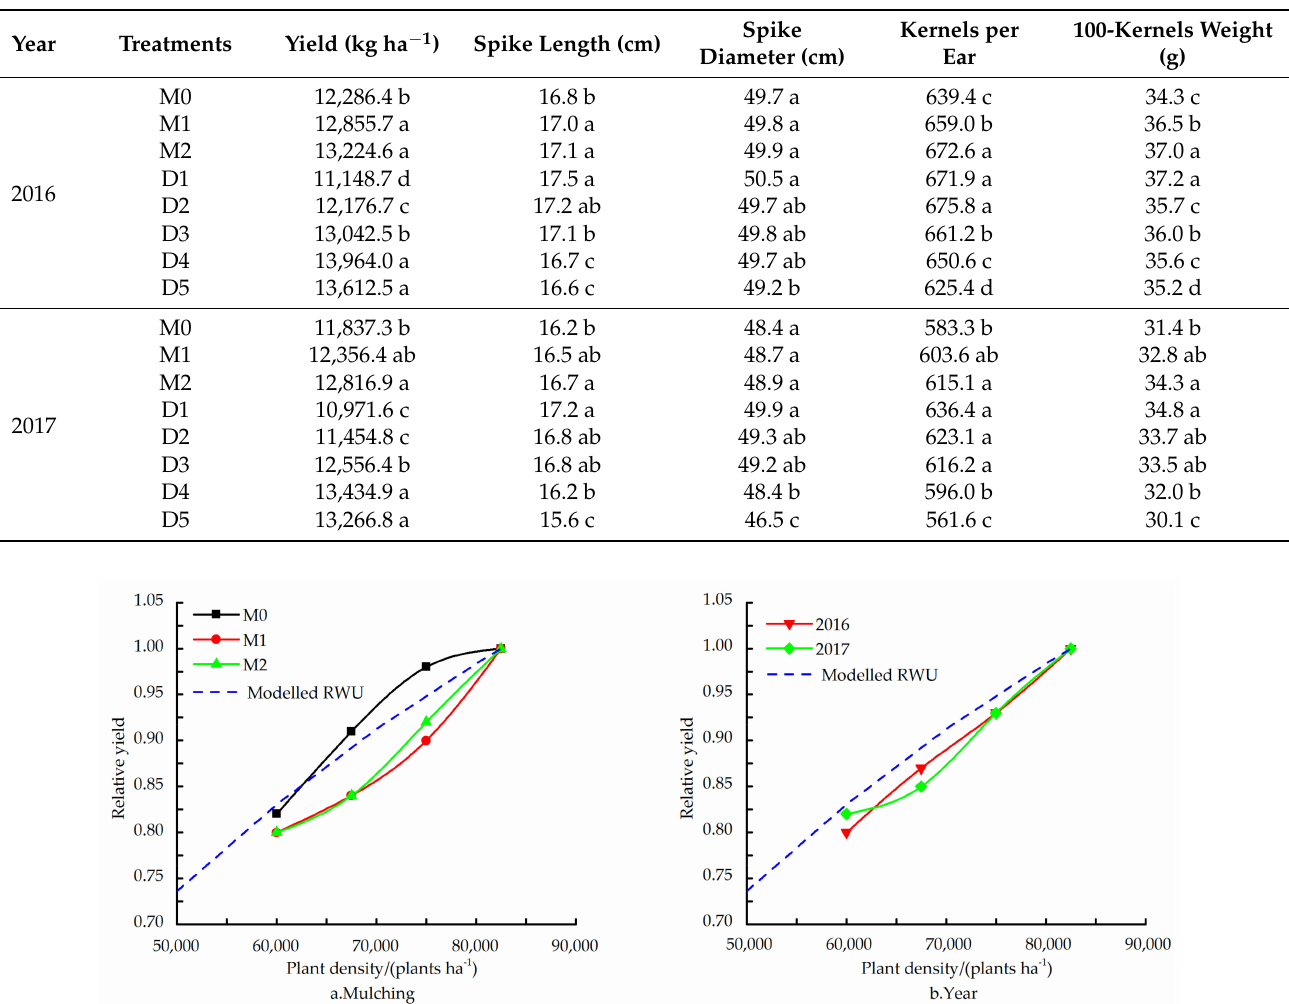
Table 4. Effects of different treatments on yield of spring maize and its components. Different letters are significantly different at the p < 0.05 probability level.